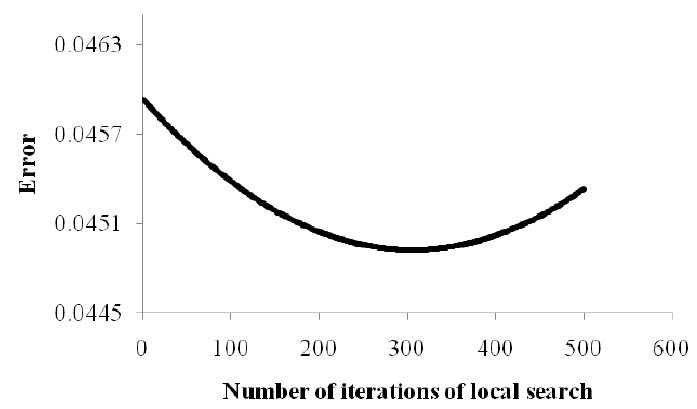
Figure 9. The effect of local search in overall